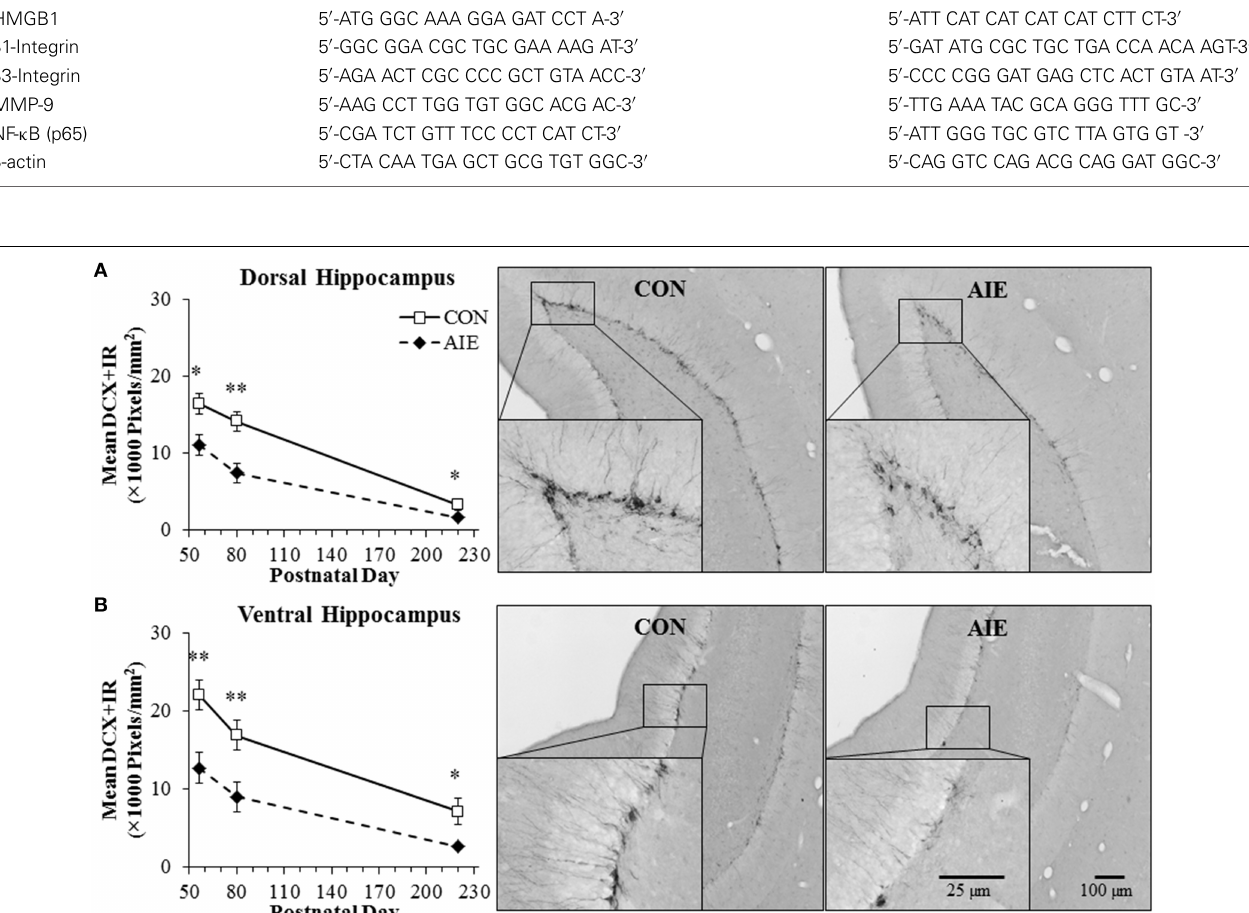
CON- and AIE-treated animals. (B) Quantification of pixel density revealed a 42% ( ± 7%) decrease of DCX + IR in the adolescent (P56) ventral hippocampal dentate gyrus that persisted from young adulthood (P80 [46 ± 9%]) into adulthood (P220 [63 ± 7%]), relative to controls (CONs). Included are representative photomicrographs of DCX + IR cells in the dentate gyrus of the ventral hippocampus from young adult (P80) CON- and AIE-treated animals. Data are presented as mean ± SEM. ∗ indicates p < 0 . 05; ∗∗ indicates p < 0 . 01, relative to CON